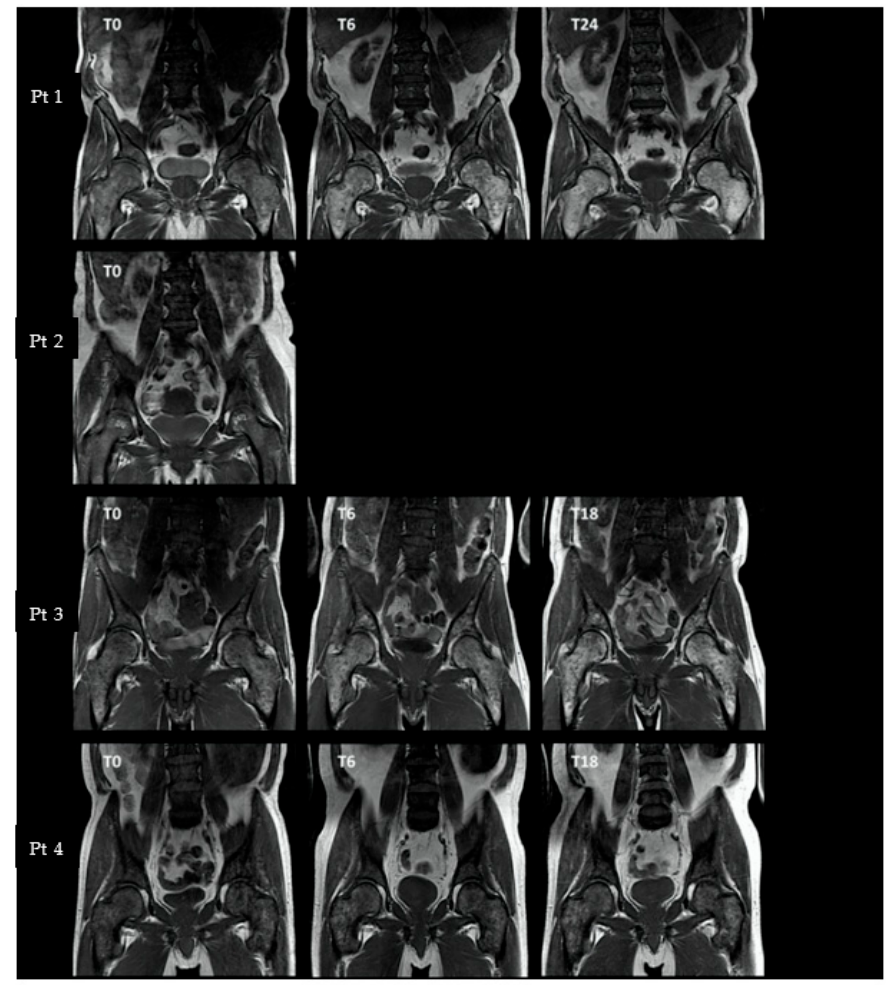
Figure 1. T1-weighted MRI images. Coronal T1-weighted images are shown for each individual patient at available time points. T0 represents the MRI at baseline, T6 the MRI at 6 months, and T18 and T24 the MRI at 18 or 24 months, respectively. Pt 1 = patient 1 (etc.). T1-signal intensity was scored based on multiple slices, using methods as outlined above. Abnormal (i.e., isointense or hypointense) vertebral, pelvic, and femoral signal intensities were seen in all patients at baseline (T0). During treatment, patients 1 and 3 showed an increase in femoral and pelvic signal intensities at T6, followed by an increase in vertebral signal intensities at T18/24. Patient 4 showed overall stable signal intensities during treatment. 3.3.2. Axial and Proximal Femoral Dixon In all four patients, baseline fat–water fractions were lowest in the vertebrae, followed by the pelvis and femoral regions (Figure 2). One patient (Pt1) showed an increase in fat–water fractions in all ROIs at both T6 and T24. The fastest increase occurred in the femora, followed by the pelvis and vertebrae, respectively. In one patient (Pt3), vertebral and femoral head fat–water fractions at T6 were stable, whilst pelvic and femoral shaft values increased slightly. At T18, femoral fat–water fractions increased further, whilst vertebral values decreased to below baseline and pelvic values remained stable. In